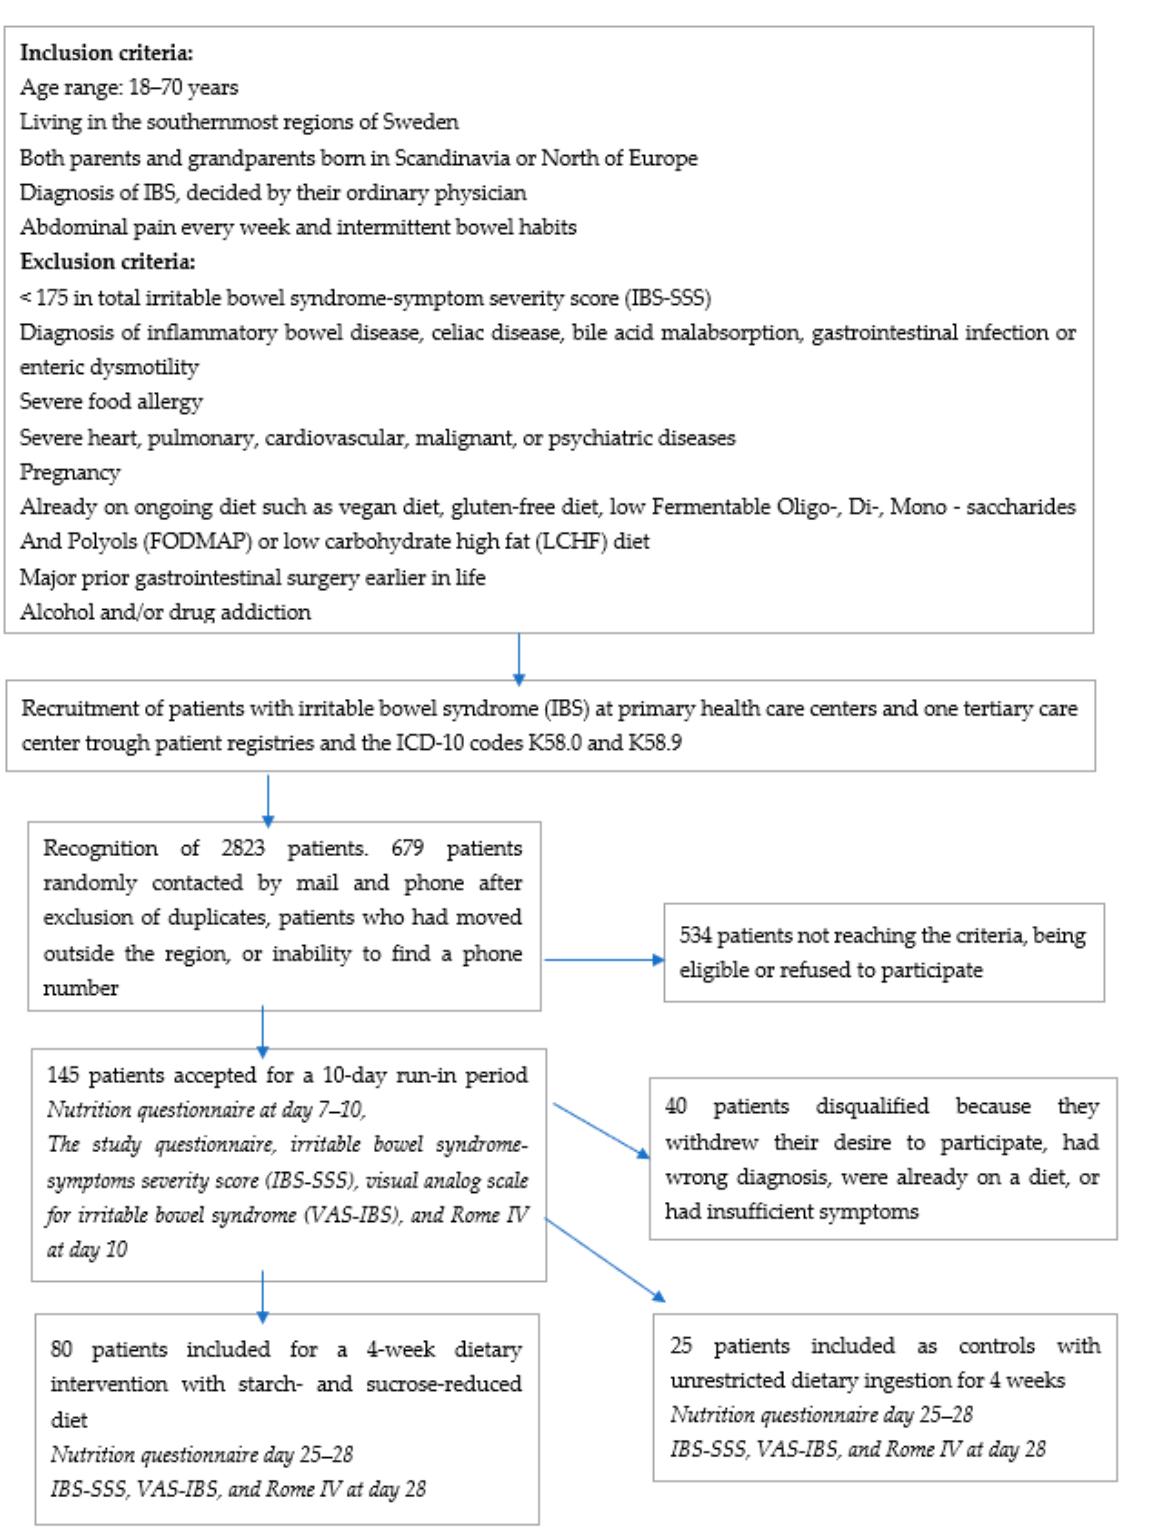
Figure 1. Study design, inclusion and exclusion criteria, and recruitment process of patients with irritable bowel syndrome (IBS) at primary healthcare centers and at one tertiary healthcare center. Patients who were willing to participate ( n = 145; 112 patients (77.2%) from PCC; 34 men (23.4%)) were sent a package of study questionnaires to complete prior to an appointment at the Internal Medicine Research Group, Skåne University Hospital,